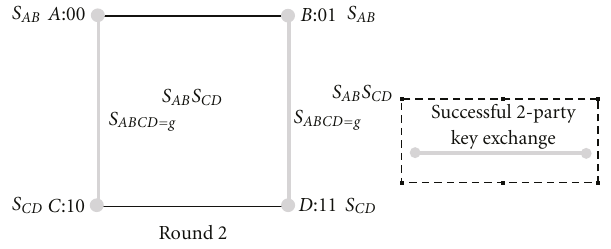
Figure 3: Asokan’s 2-d cube round 2.